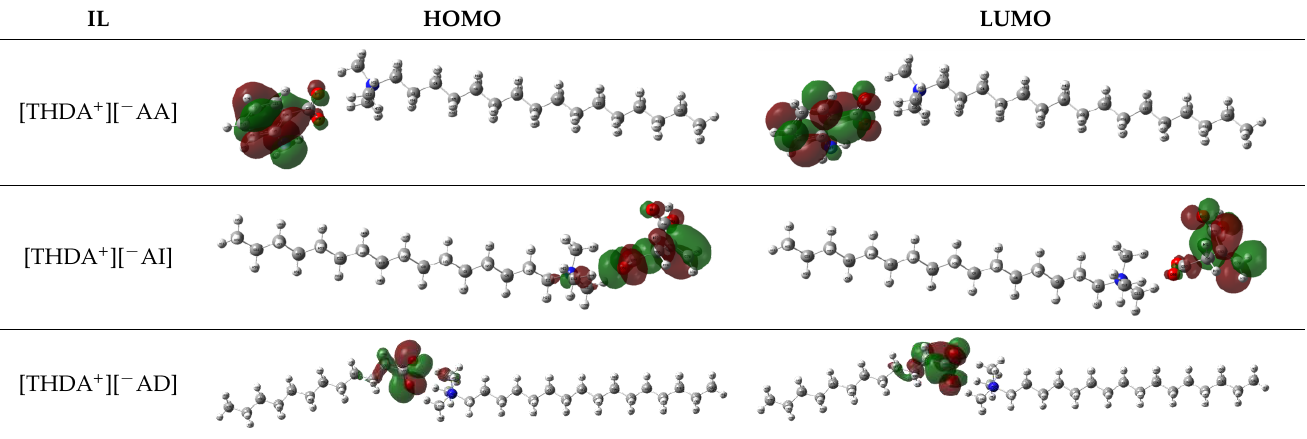
Table 6. Molecular orbitals of the ILs obtained at the B3LYP/6-311G level in aqueous medium.